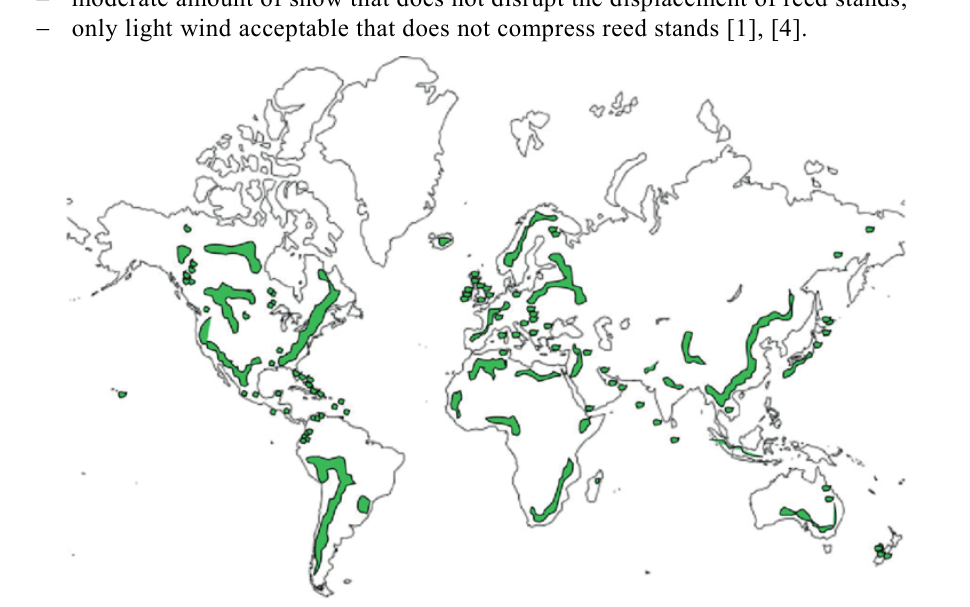
Fig.1. Reed biomass global availability